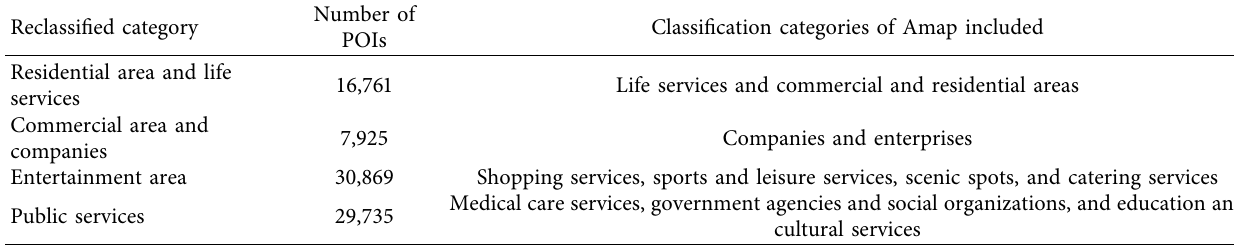
Table 2: POI reclassification table.